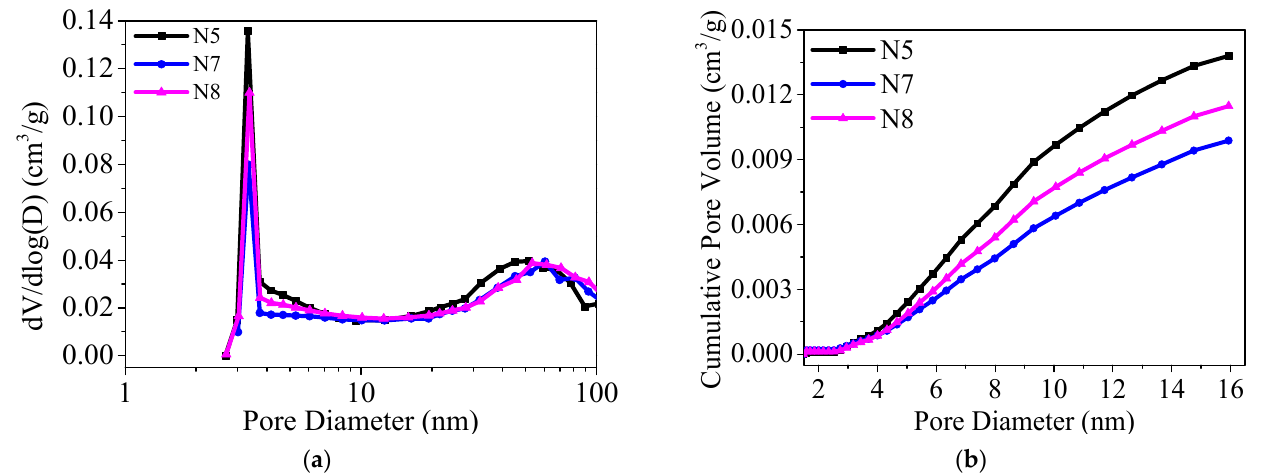
Figure 10. Cumulative intrusion curves ( a ) and pore size distribution ( b ) of cement-based materials doped with 0, 0.16, and 0.24 wt% NSN.